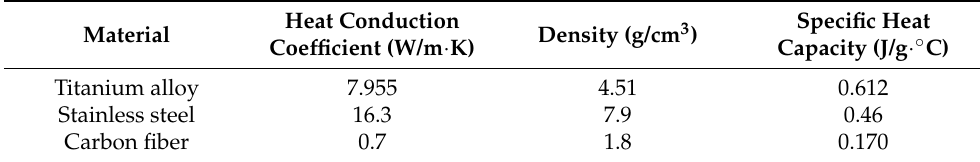
Figure 6. Result of rotor eddy current loss analysis with different speeds for three types of sleeve materials. Table 2. Thermal conductivity of different sleeve materials.